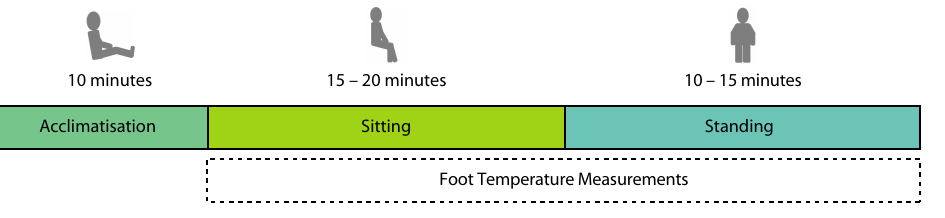
Figure 5. Experimental protocol for the second session of the experimental protocol which was used to collect the temperature